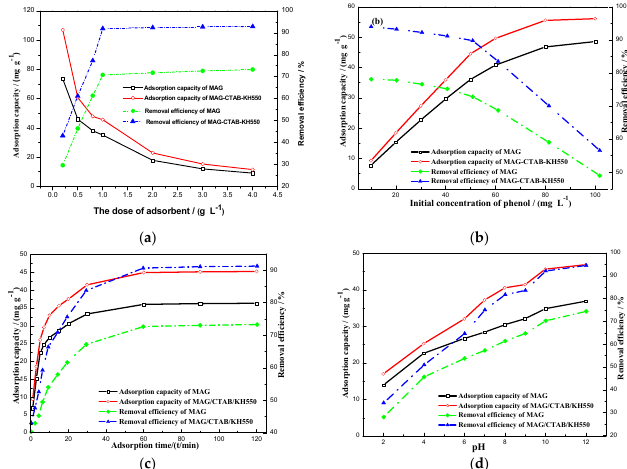
Figure 5. ( a ) Effects of adsorbent dosage of MAG and MAG–CTAB–KH550 on removal efficiency and adsorption capacity of phenol (in the conditions of pH = 10, and the adsorption time for 60 min); ( b ) Effects of initial concentration of phenol on the removal efficiency and adsorption capacity under the conditions of sorbents dosage of 1 g/L and adsorption equilibrium time for 60 min, and pH value of 10; ( c ) Effects of adsorption time on adsorption capacity of phenol under the conditions of initial concentration of phenol at 50 mg/L, pH of 10, and the sorbents dosage of 1 g/L; and ( d ) Effects of pH values of the solution on adsorption capacity of phenol under the conditions of initial concentration of phenol at 50 mg/L, sorbents dosage of 1 g/L, and adsorption equilibrium time of 60 min.